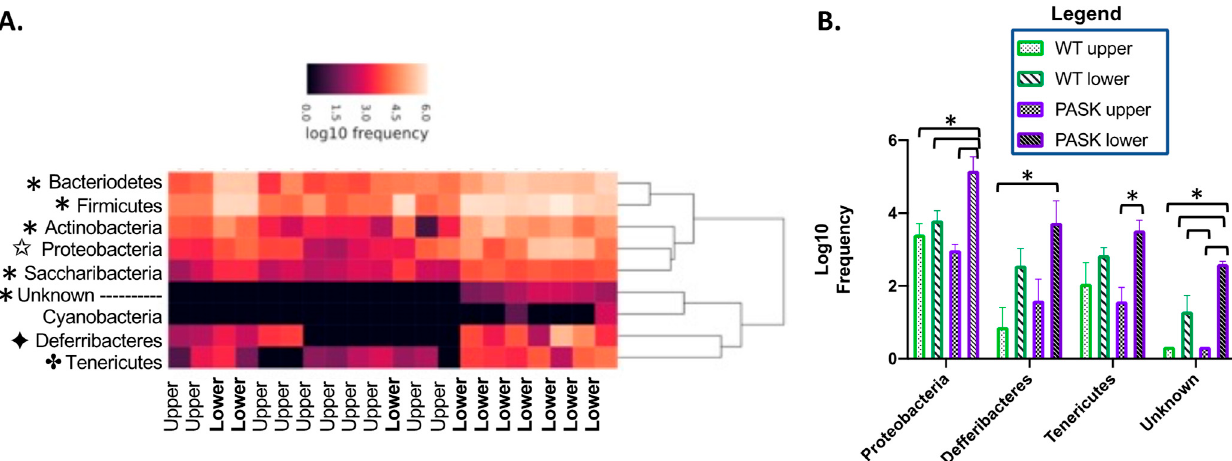
Figure 5. Diet protects against microbiome imbalance. ( A ) Heatmap of week 22 male HFHS samples with upper or lower cluster indicated on the x-axis. “*” indicates differences between all lower groups when compared with all upper groups ( p < 0.05). “ ✦ ” indicates significance with WT upper and PASK lower clusters only, “ ✤ ” is PASK upper with PASK lower only, while “ ✩” indicates the PASK lower cluster mice are significant with respect to all other cohorts ( p < 0.05). ( B ) Four phyla displayed differences between the WT and PASK upper and lower cluster cohorts. “*” indicates p- value < 0.05. Factorial ANOVA in JMP Pro 14 was utilized followed by post hoc Tukey HSD analysis to determine significant differences between cohorts.